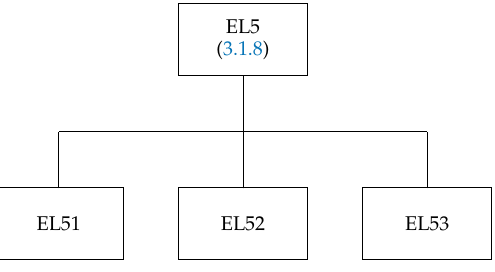
Figure 8. Global structure of the subroutine EL5 .